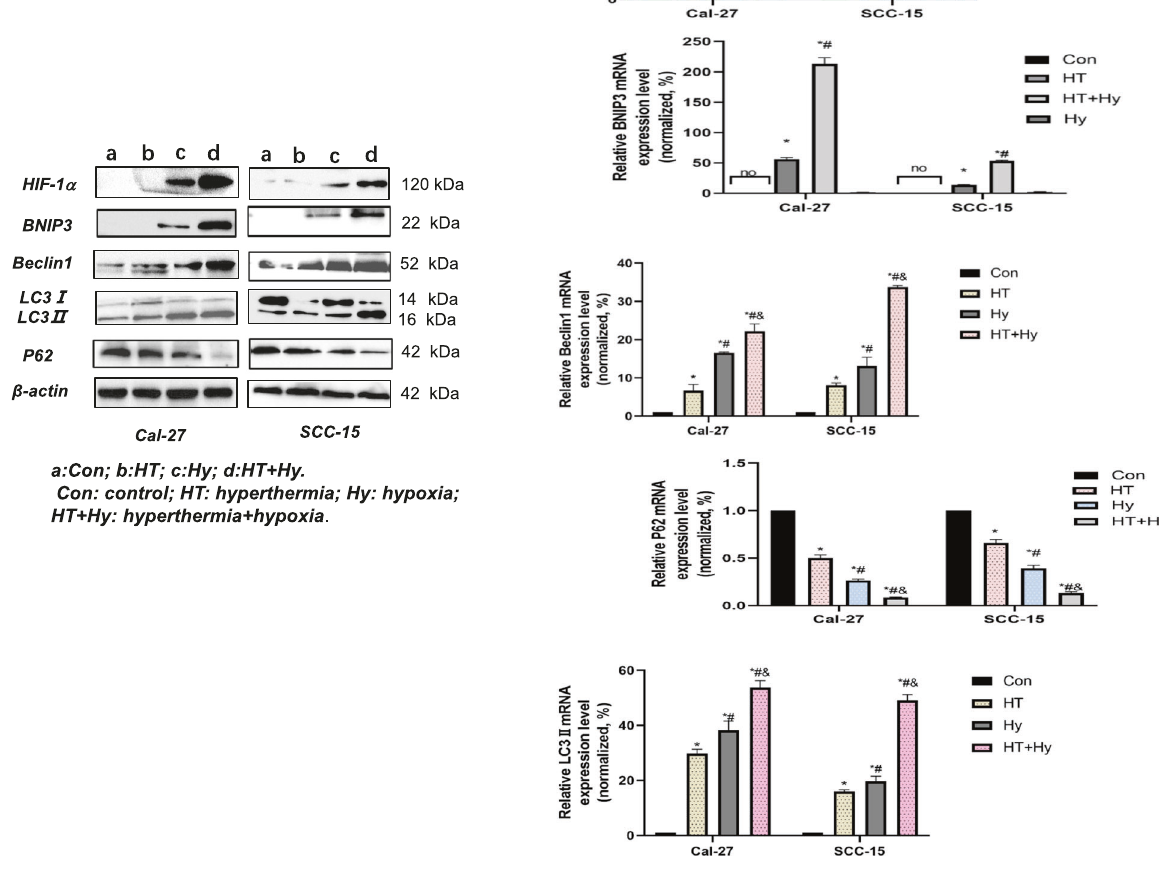
Fig. 4 Hyperthermia and hypoxia-induced the expression of autophagy hallmark proteins in OSCC cells. Cal-27 and SCC-15 cells were cultured in hypoxia conditions and were exposed to 42 °C for 1 h, followed by recovery at 37 °C for 24 h. The protein and mRNA levels of HIF- 1 α , BNIP3, Beclin1, LC3-II, and p62 were analyzed by qRT-PCR and western blot and normalized to those of β -actin. Data were expressed as the mean ± SEM from three independent experiments. a: Con; b: HT; c: Hy; d: HT + Hy. Con control, HT hyperthermia, Hy hypoxia, HT +